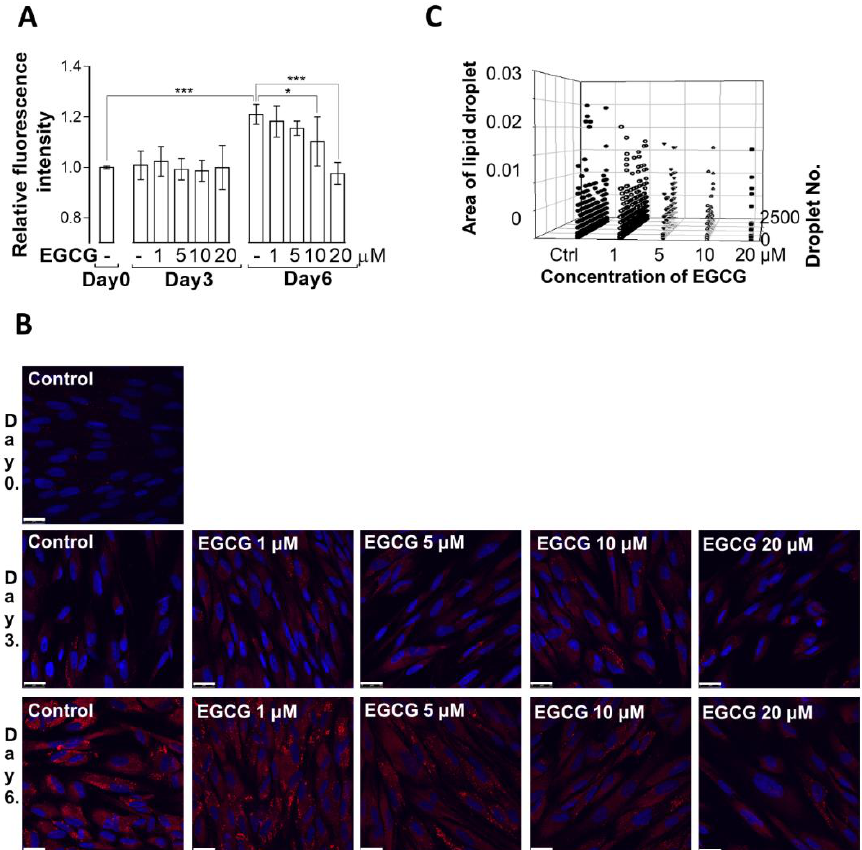
Figure 1. Detection of lipid droplets in MSCs during adipogenic differentiation. MSCs were differen- tiated in the absence or presence of 1, 5, 10, and 20 µ M EGCG, and lipid droplet accumulation was detected in differentiated cells with Nile red dye. ( A ) Lipid droplets in cells in a 96-well plate assay on days 0, 3, and 6 of differentiation using a fluorescent plate reader. Treatments were compared with a two-way ANOVA; * p < 0.05, *** p < 0.001; n.s. nonsignificant; n = 7. ( B ) Lipid droplets (red) stained on coverslips on day 6 and imaged by confocal microscopy. Scale bar: 25 µ m. ( C ) The number (right axis) and size (left axis) of lipid droplets as a function of EGCG concentration analyzed by